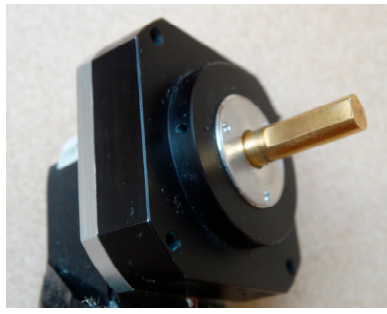
Figure 2. PUMR 40E, Piezoelectric Technology Co., Ltd., Seoul, Korea.